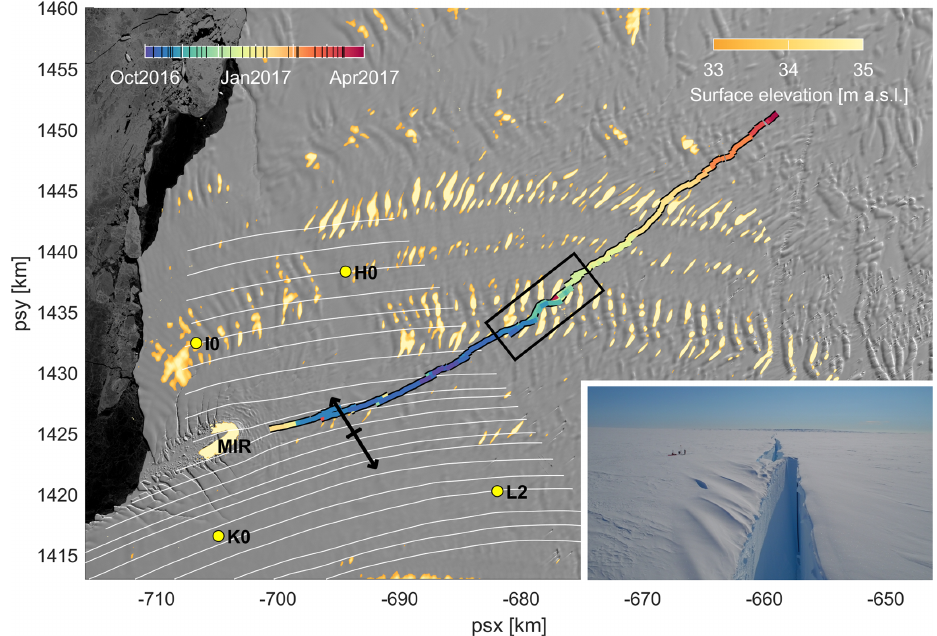
Figure 4. Extent of Halloween Crack (HC) based on a time series of manual outlines from Landsat 8 and Sentinel-2 images; the corresponding dates are indicated by black ticks in the colour bar. The background image is a Landsat 8 scene from 15 March 2017, the yellow dots correspond to the location of four permanent GPS stations ( K 0, I 0, H 0 and L 2), and the inset in the lower right shows an aerial image of the HC taken in January 2017 from a location 5km to the east of the MIR. Orange-to-yellow colours highlight areas with a surface elevation above 33m, and the black box outlines an area where the HC cuts through a band of thicker ice. White lines are flow lines based on a velocity field from 2015, prior to the formation of the HC, and indicate a localized divergence of flow around the MIR. The strain rosette is calculated from the differential motion of L 2, K 0 and H 0 between 3 October 2016 and 1 February